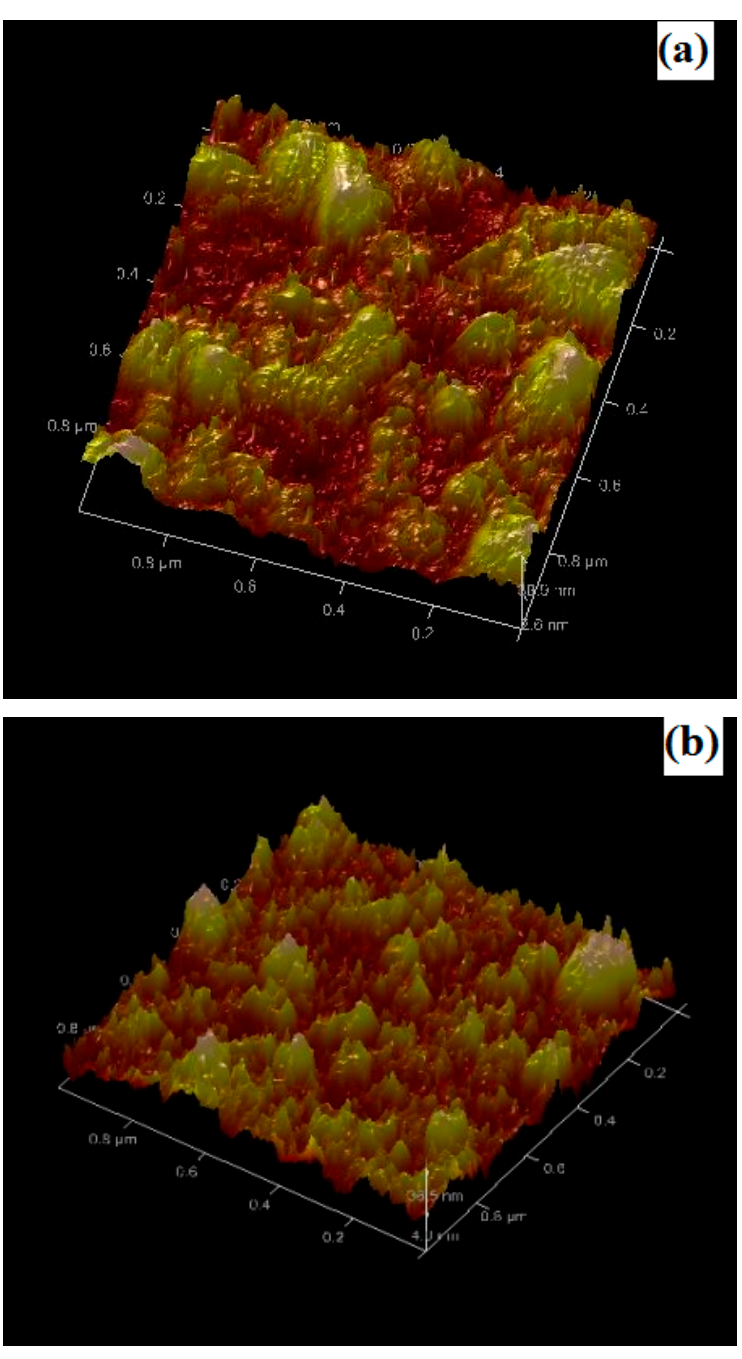
Figure 3. AFM images of Yb 3 + / Tb 3 + co-doped ZnO thin films: ( a ) ZnO: 5% Yb 3 + -1% Tb 3 + , ( b ) ZnO:5% Yb 3 + -3% Tb 3 + .